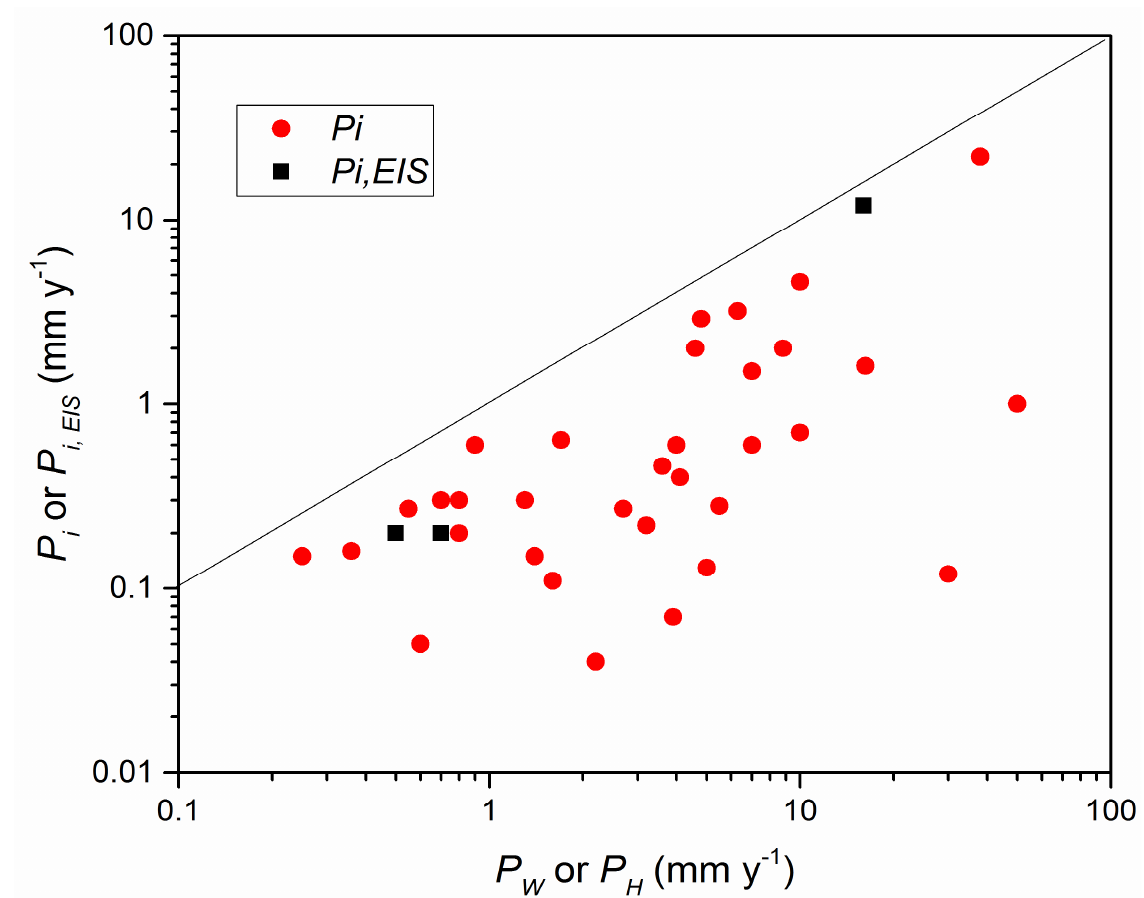
Figure 4. Typical data from a recent compilation of experiment measurements [83]. Mg corrosion rates were measured by electrochemical methods (Mg corrosion rates measured by Tafel extrapo- lation of polarization curves, P i , and using electrochemical impedance spectroscopy, P EIS .) These measurements were cross plotted against independent measurements made in the same paper of the steady state corrosion rate as measured by weight loss, P W , or by hydrogen evolution, P H . The line drawn in the figure is a guide to the eye and shows the condition of equality. The experimental measurements clearly show that the Mg corrosion rates measured by electrochemical methods did not agree with the steady state corrosion rates measured by weight loss or hydrogen evolution.